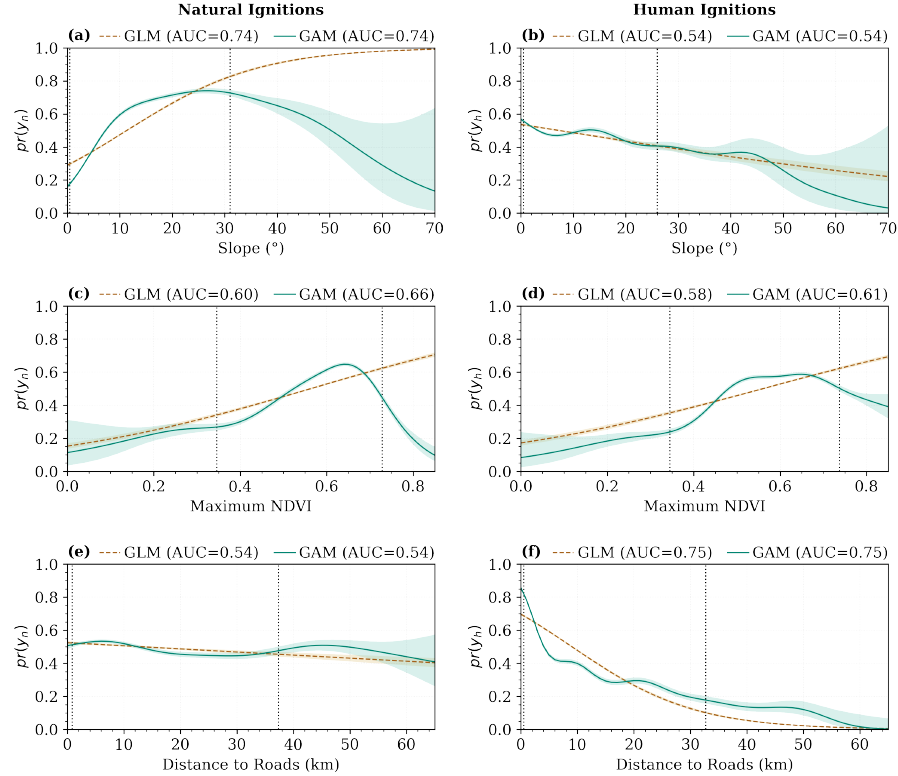
Figure 4. Univariate simple logistic general linear models (GLMs) and simple logistic general additive models (GAMs) to predict the probability of natural ignitions, pr ( y n ) ( left column ), and human- caused ignitions, pr ( y h ) ( right column ). Models were built using a single explanatory variable each, shown for slope ( a , b ), maximum NDVI ( c , d ) and distance to roads ( e , f ). The dotted vertical lines indicate the 5th and 95th percentiles of the explanatory variables and therefore capture 90% of the training data. The area under the receiver operating characteristic curve (AUC) is based on the testing